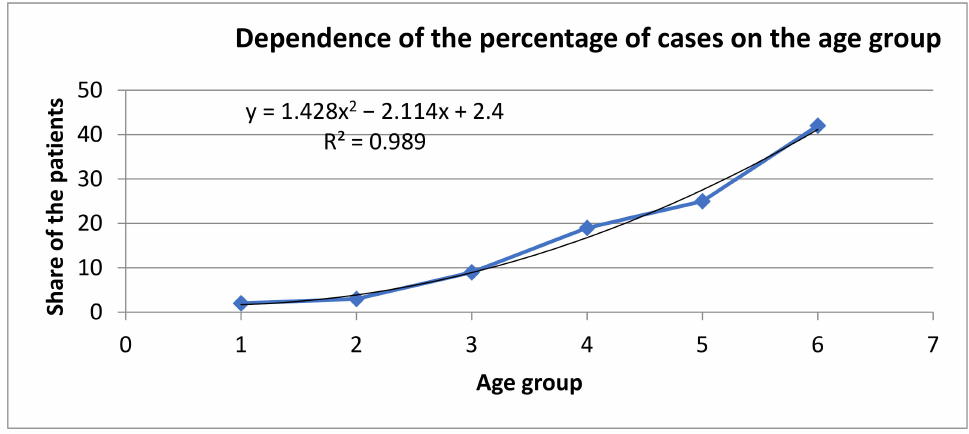
Figure 10. Dependence of the percentage of cases on age